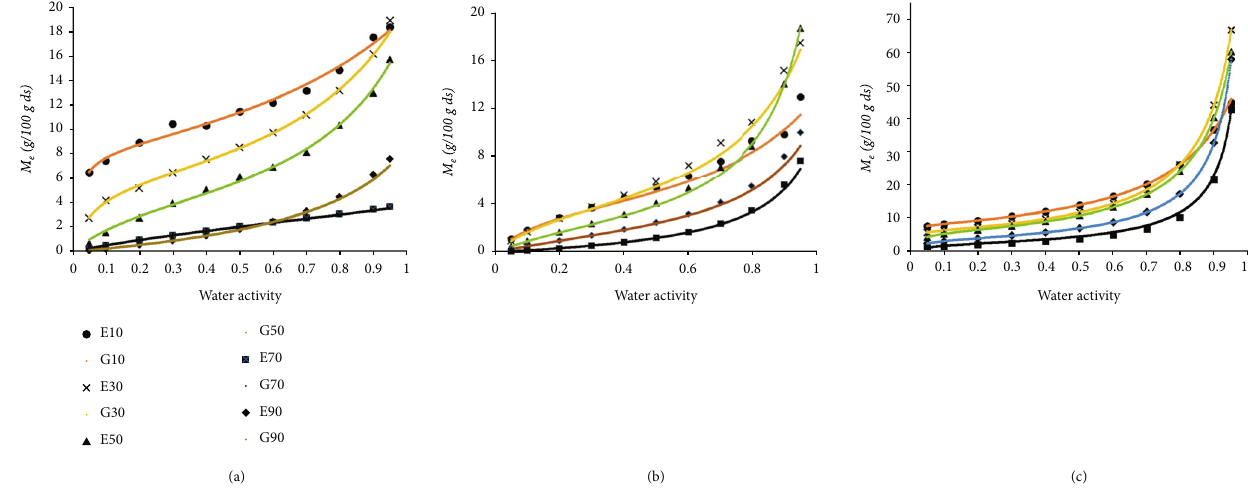
Figure 5: Adsorption isotherms of cellulose, lignin, and hemicellulase at temperature from 10 to 90 °